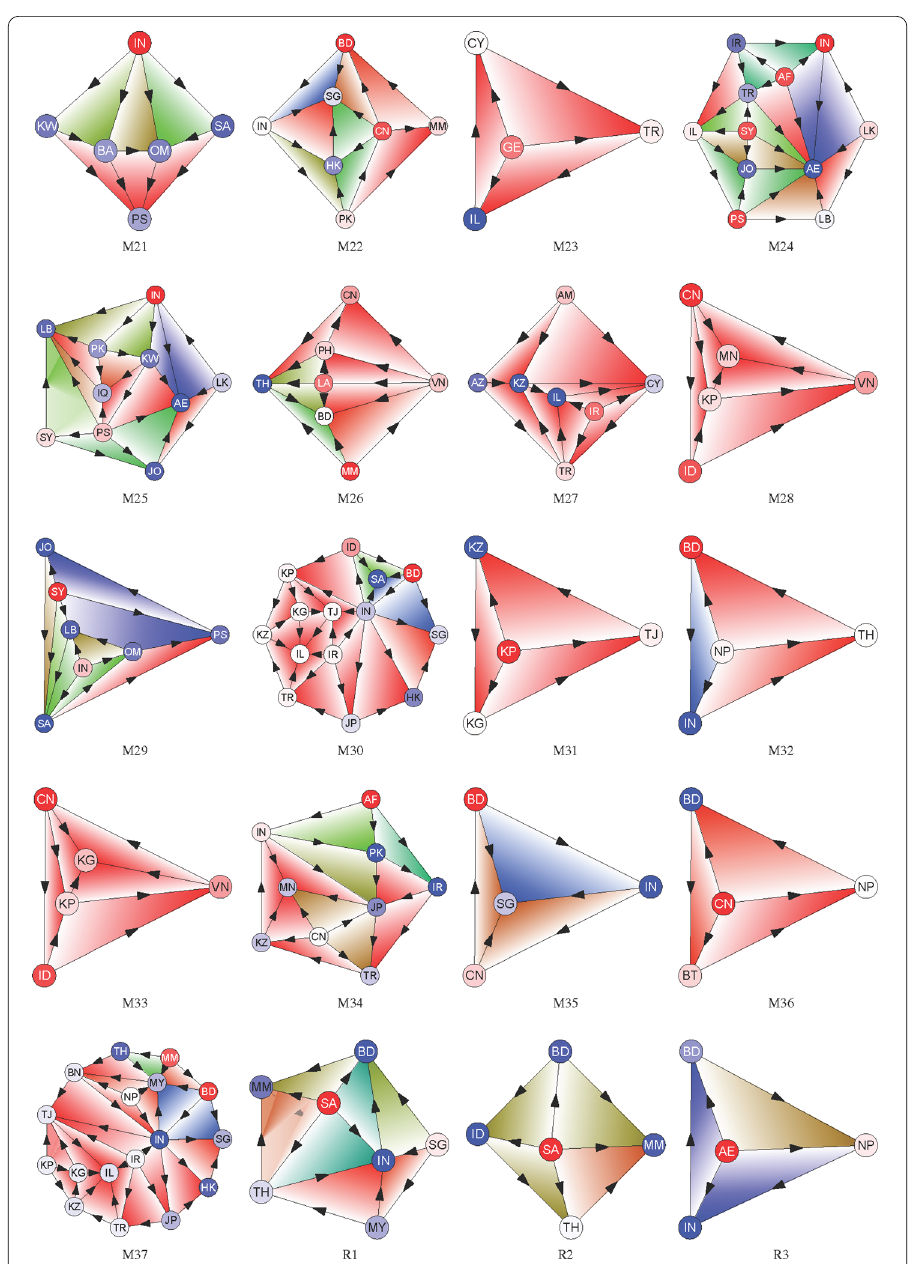
Figure 13 Spherical patterns within the Asian migration and Remittance networks continued. 2-cycle generators for the 2015 Asian net migration (M1-M37) and remittance (R1-R42)